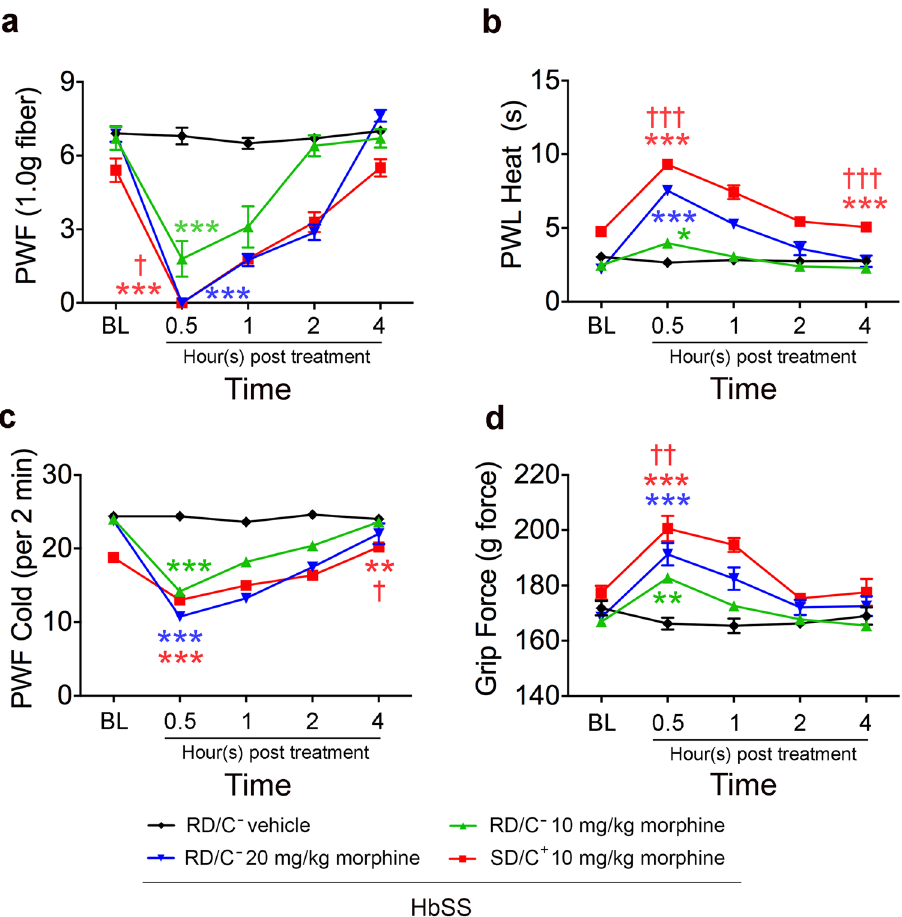
Figure 6. Effect of enriched diet and companionship on analgesic effect of sub-optimal dose of morphine in male sickle mice. Male sickle mice housed singly without a companion fed with regular diet (RD/C −) were treated with vehicle, and 3 or 10 mg/Kg morphine sulfate. Another group of male mice fed sickle diet and housed with a female companion were treated with 10 mg/kg morphine sulfate. Hyperalgesia measures for all mice are shown for, mechanical hyperalgesia as PWF in response to 1.0 g von Frey filaments; heat hyperalgesia as PWL in response to a heat stimulus; cold hyperalgesia as PWF per 2 min on a cold plate at 4 °C and deep tissue/musculoskeletal hyperalgesia as grip force exerted by forelimbs. Male HbSS-BERK mice between 8 and 10 months of age were used. Regular diet without companionship, RD/C−, nSS vehicle = 5, nSS 10 mg/kg morphine = 5, nSS 20 mg/kg morphine = 5; sickle diet with companionship, SD/C+, nSS 10 mg/kg morphine = 5; mixed linear models with Tukey’s post-hoc test, * p < 0.05, ** p < 0.01, *** p < 0.001 compared to RD/C− with vehicle; † p < 0.05, †† p < 0.01, ††† p < 0.001 compared to RD/C− with 10 mg/kg morphine. PWF paw withdrawal frequency; PWL paw withdrawal